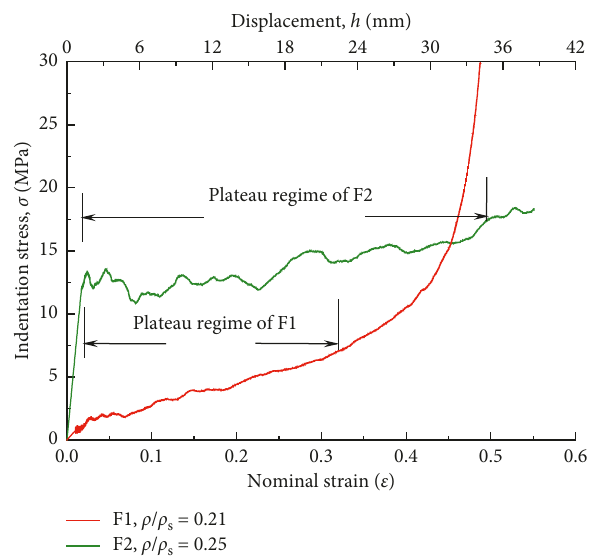
Figure 6: Relative compressive strength, σ relative density, ρ / ρ s , for two kinds of Al foams.